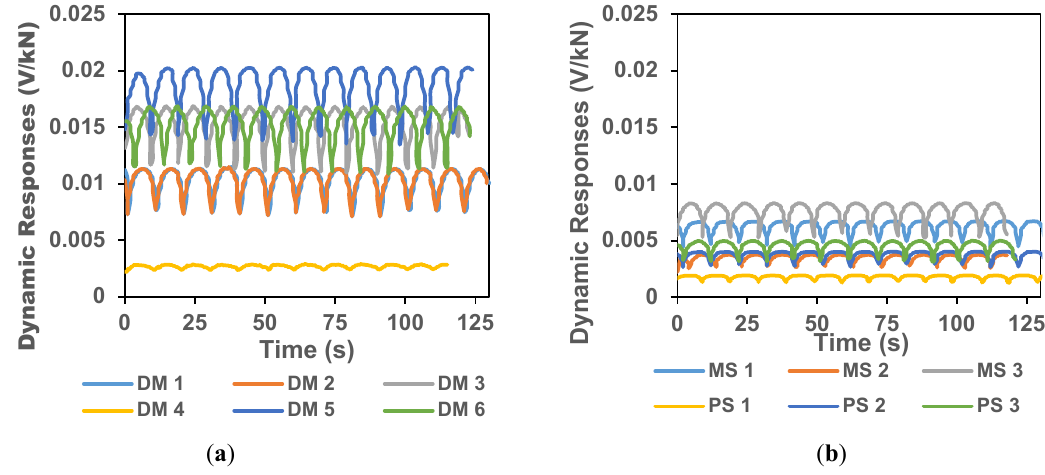
Figure 8. Dynamic responses in sample block impregnated with 0.1% bare CNTs using direct mixing method ( a ) and from the controls Group MS (only modified tapioca starch but no CNTs) and Group PS (no CNTs and modified tapioca starch) ( b ). The multiple plots represent responses from each sample from Group DM.